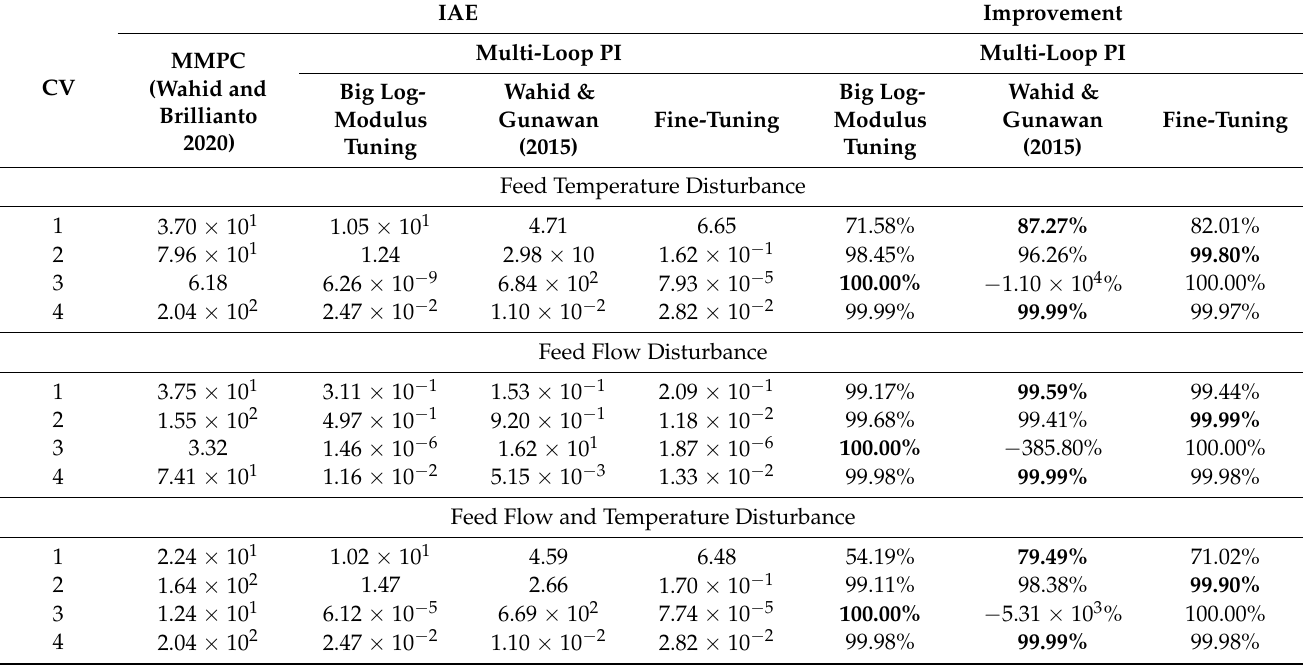
Table 10. IAE comparison of MMPC and multi-loop PI against disturbance